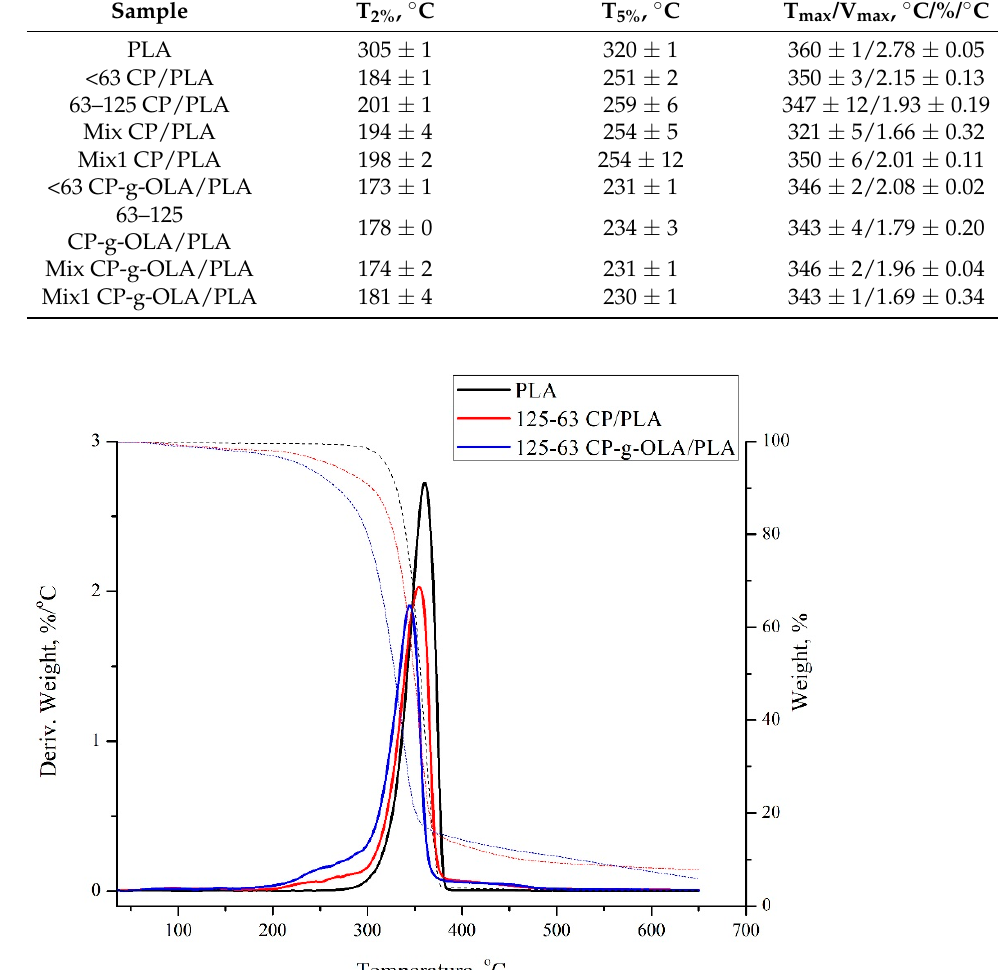
Table 9. TGA results of PLA and biocomposites.